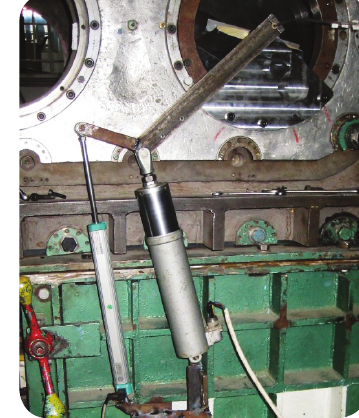
Figure 6. PSD values of a hot wire.